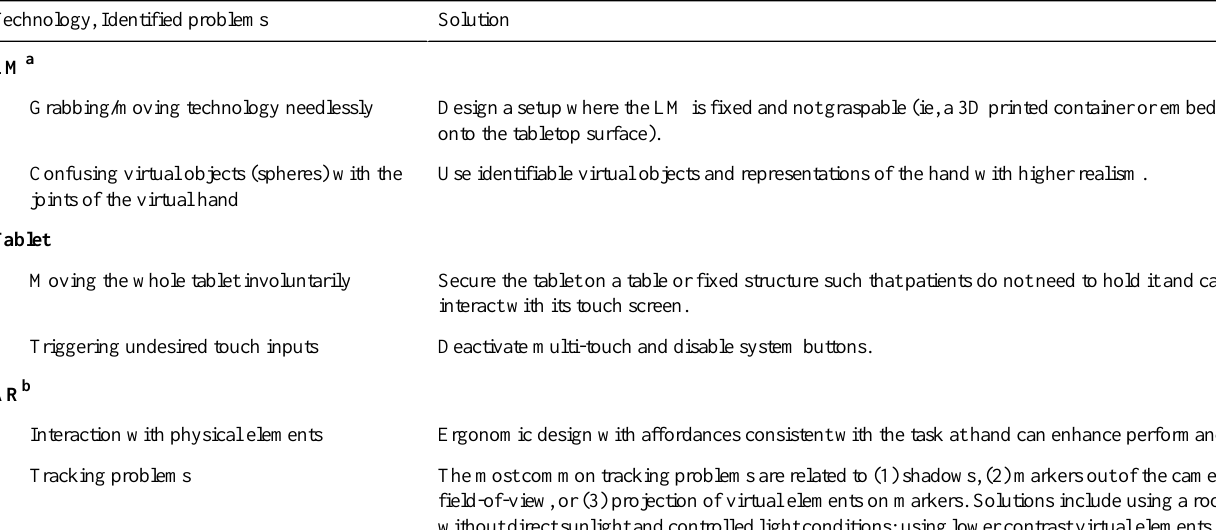
Table 4. Identification of problems and proposed recommendations or using technology to perform virtual tasks by people with